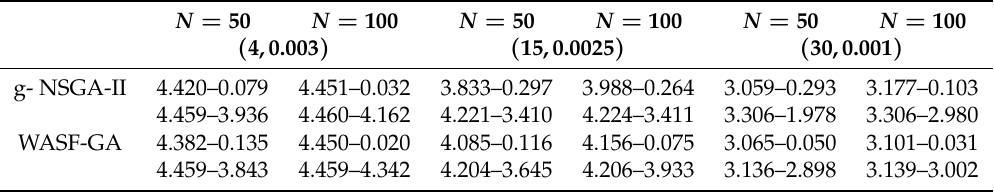
Table 3. Comparison and statistical results of the mean, standard deviation values (upper), and the best and worst hypervolume values (lower), respectively, for three different DM’s partial-preferences ( 4,0.003 ) , ( 15,0.0025 ) and ( 30,0.001 ) for g-NSGA-II and